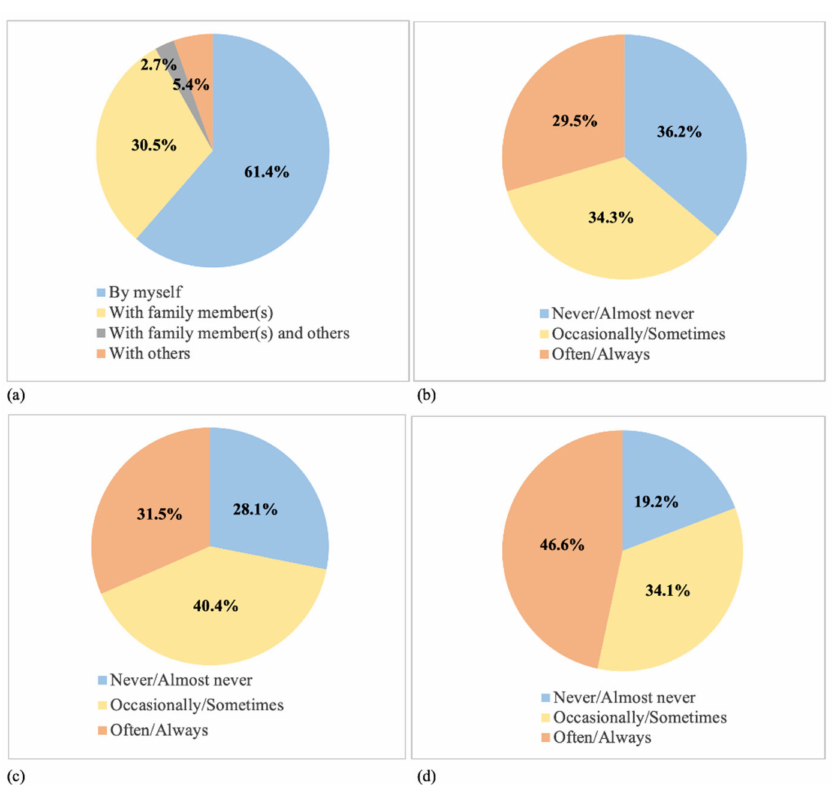
Figure 3. Mode of PA among participants who reported engaging in PA during lockdown (n = 8995): ( a ) with whom PA was engaged, ( b ) frequency of using online programs, ( c ) frequency of using PA as a coping strategy, and ( d ) frequency of encouraging others to engage in